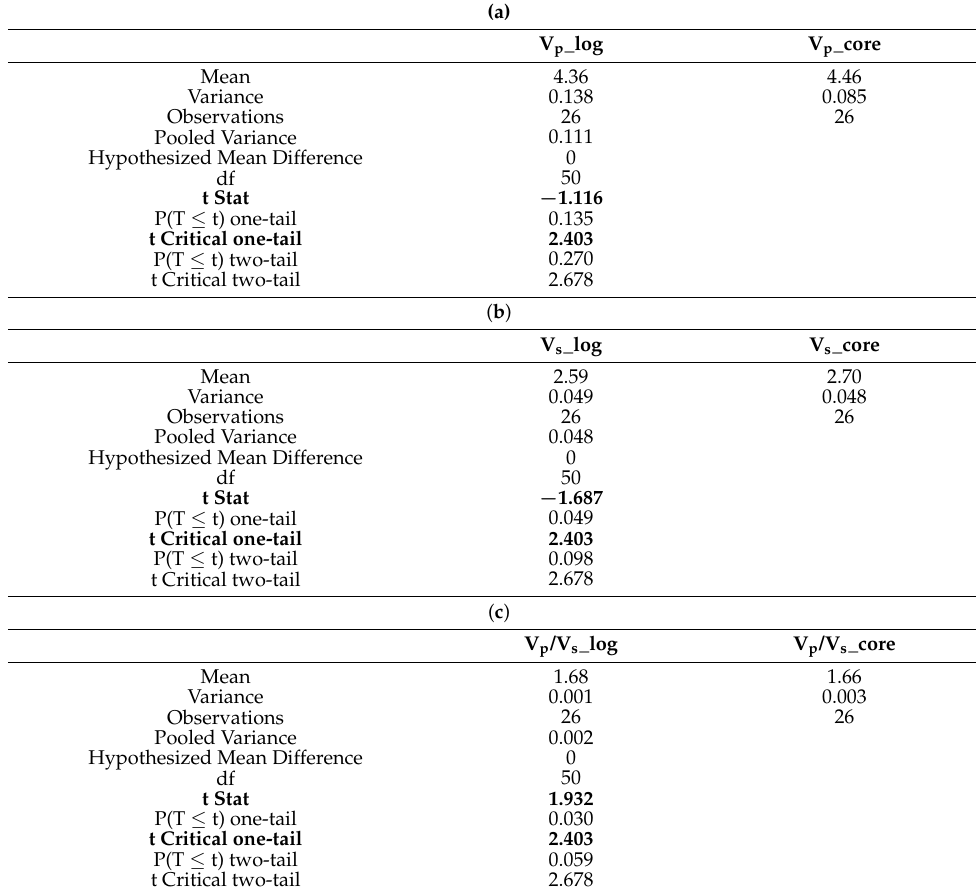
Table 8. (a) Student t -test for the sonic log and ultrasonic core P-wave velocity measurements (after fluid substitution to in situ saturations—labeled as V p2 in the following tables) for all four formations combined. The results indicate there is no significant difference between the mean of the sonic log and ultrasonic core measurements. (b) Student t -test for the sonic log and ultrasonic core S-wave velocity measurements (after fluid substitution to in situ saturations—V s2 ) for all four formations combined. The results indicate there is no significant difference between the mean of the sonic log and ultrasonic core measurements. (c) Student t -test for the sonic log and ultrasonic core V p /V s ratio (after fluid substitution to in situ saturations) for all four shale formations combined. The results indicate that there is no significant difference between the mean of the sonic log and ultrasonic core velocity